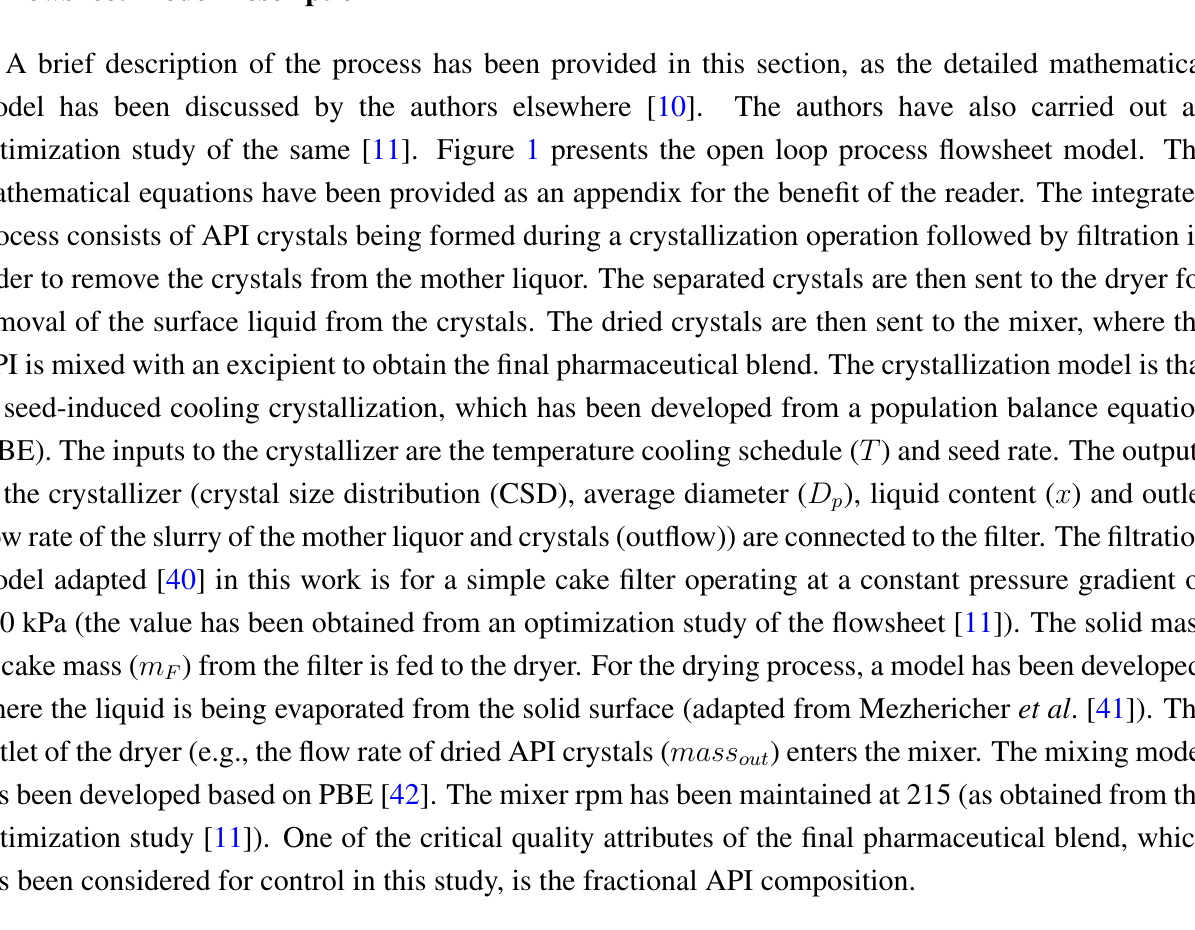
Figure 1. Pictorial representation of the open loop continuous